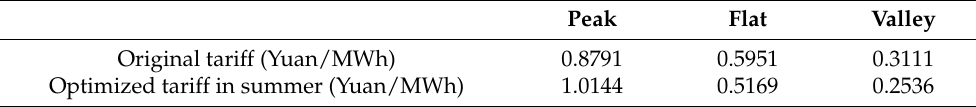
Table 5. The TOU tariff optimization results in summer.